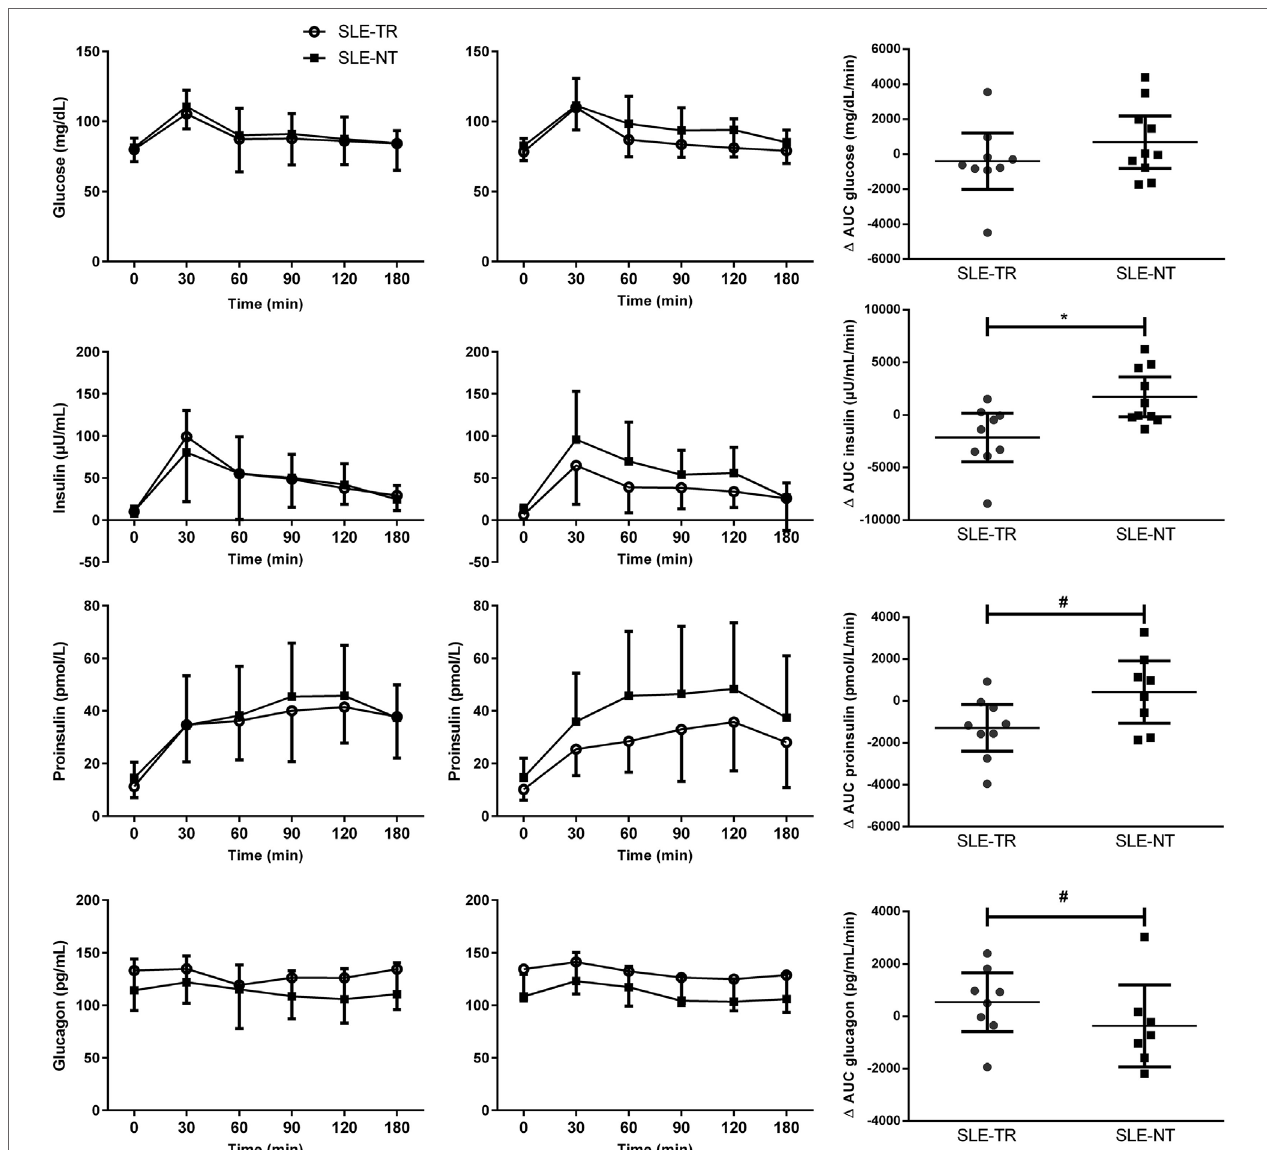
FIGURE 2 | Insulin sensitivity and beta-cell function estimates in SLE-TR and SLE-NT (Pre and Post data and delta changes). Data are expressed as mean ± SD. SLE, systemic lupus erythematosus; SLE-TR, trained group (open circles); SLE-NT, non-trained group (black squares); AUC, area under the curve calculated from the response to the meal test. Mixed model tests adjusted by Pre values were used to assess possible differences in delta changes between groups. * p < 0.05, SLE-TR vs. SLE-NT; # p < 0.09, SLE-TR vs.